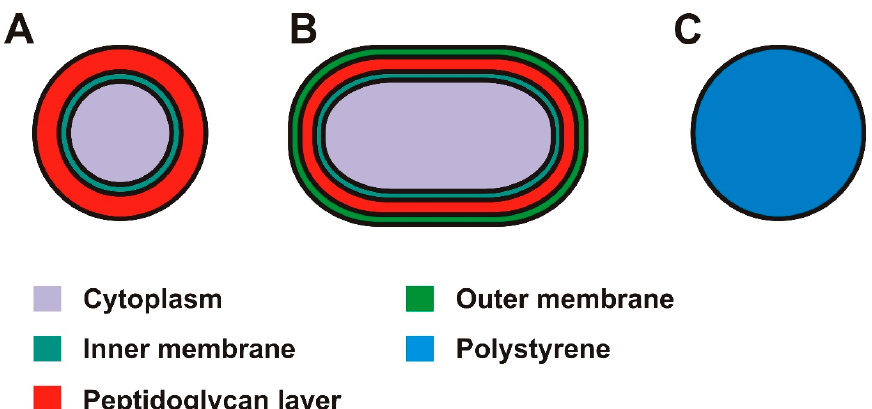
Figure 1. Schematic drawings of the bacteria and particles used in this report ( A ) Gram-positive S . Aureus ( B ) Gram- negative E . coli . ( C ) Polystyrene beads. S . Aureus ( B ) Gram- negative E. coli . ( C ) Polystyrene